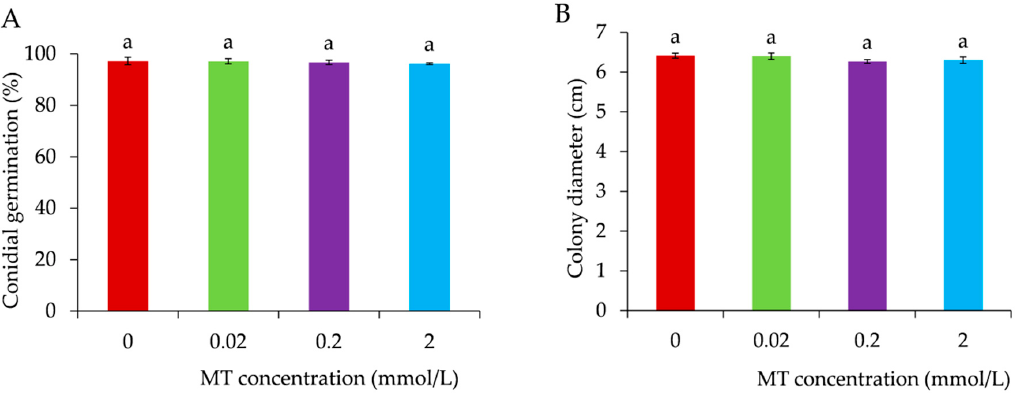
Figure 1. Effect of melatonin on conidial germination ( A ) and mycelial growth ( B ) of B. cinerea . Data represent means ± S.E. ( n = 3). Duncan’s multiple range test was used to analyse significant differences in data, and letters above the bars represent differences at p < 0.05.